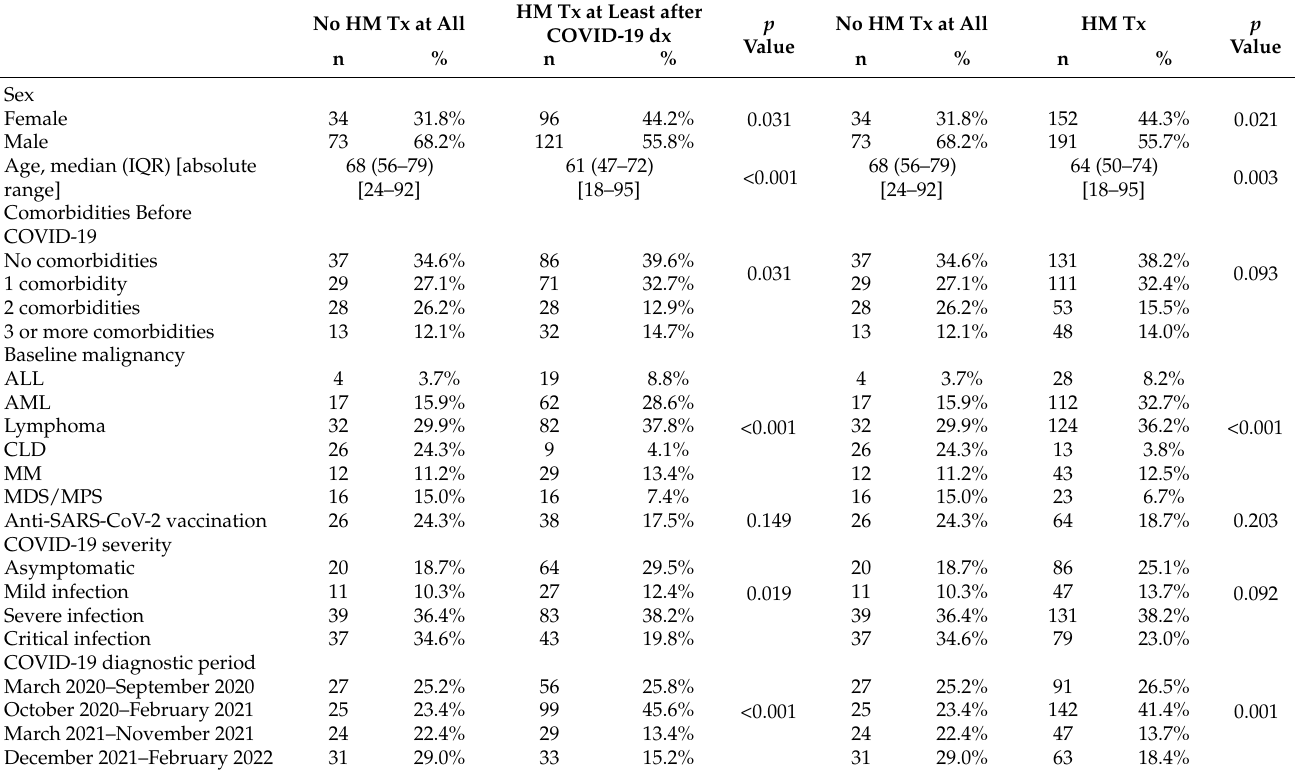
Table 2. Clinical characteristics of treated and not treated